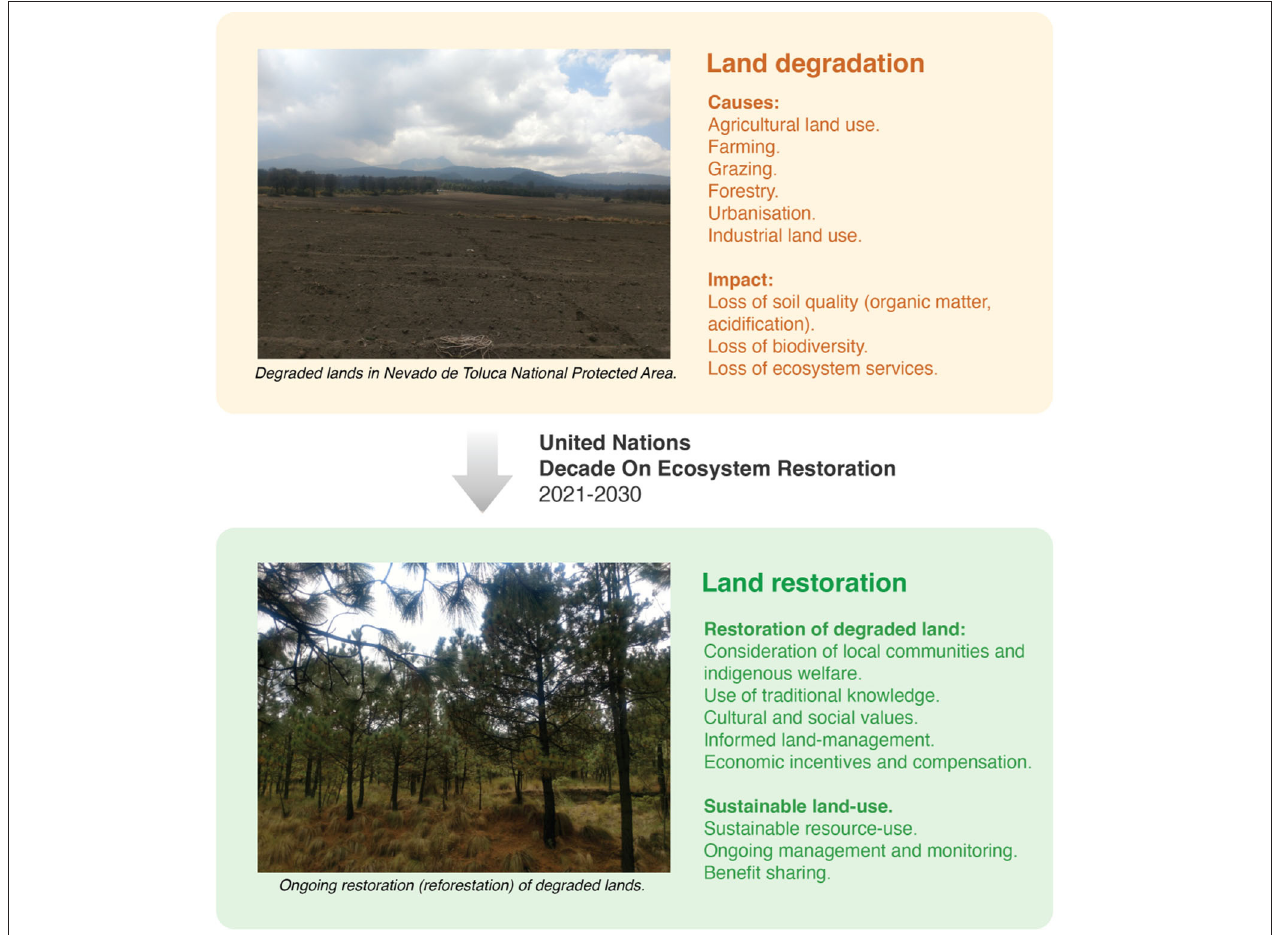
FIGURE 1 | Effective land restoration requires integrating scientific and local